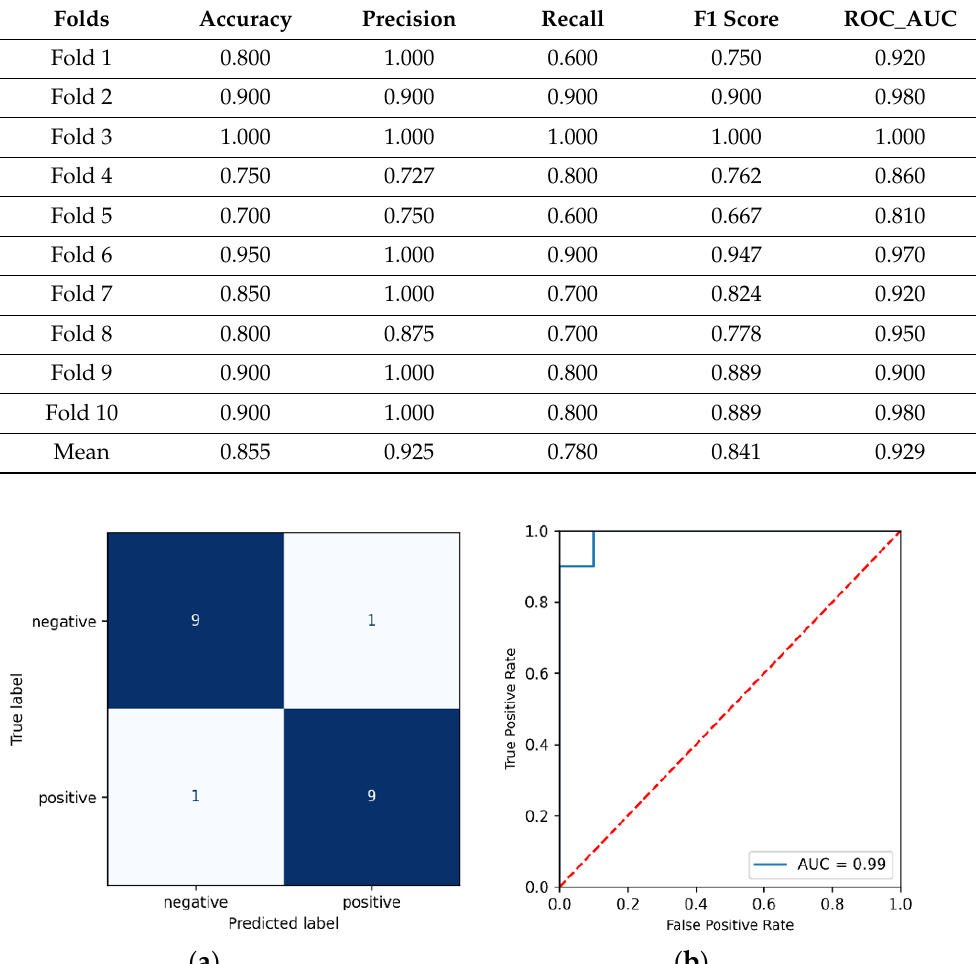
Table 2. Result from 10-Fold validation of GPR model with 4 UMAP Dimensions.